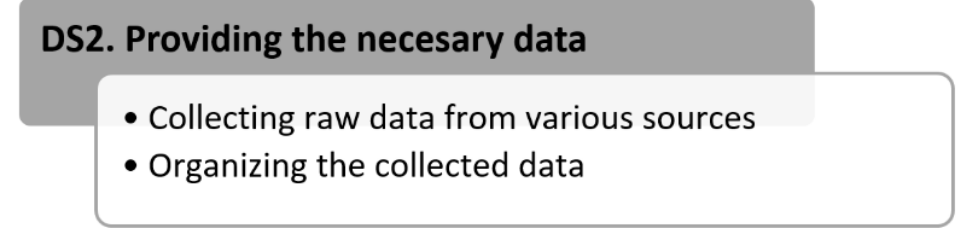
Figure 3. Design of CSFs: Stage 2.